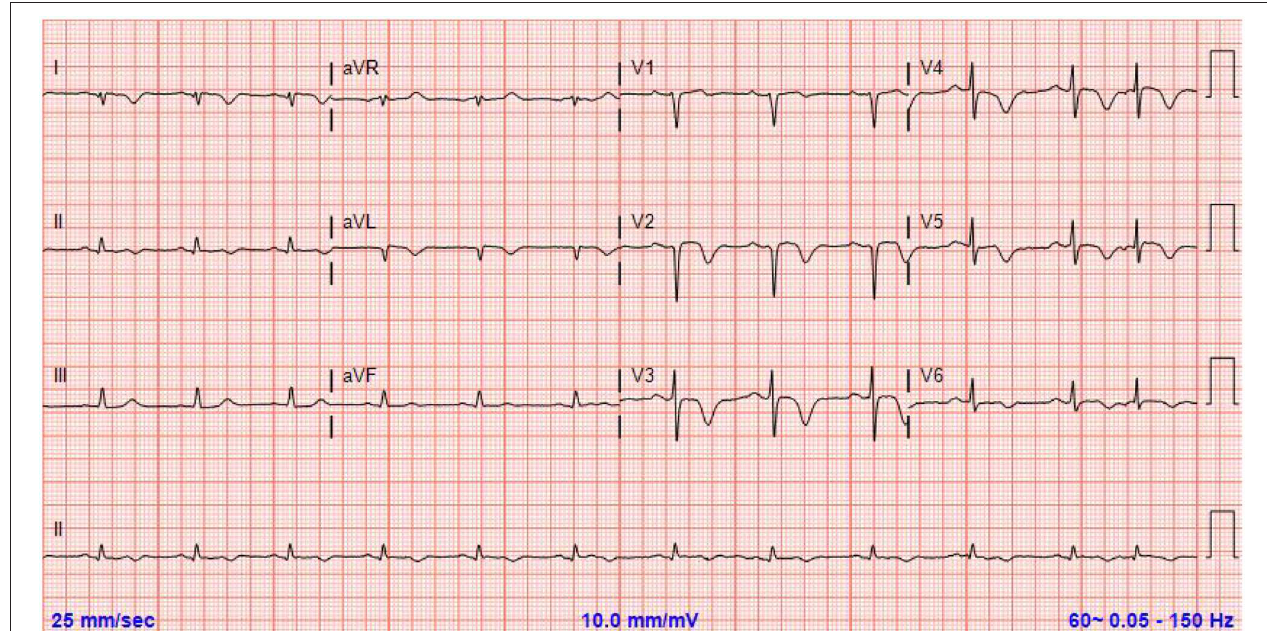
FIGURE 1 | Electrocardiograme demonstrating symmetrical T wave inversions in the anterolateral leads concerning for